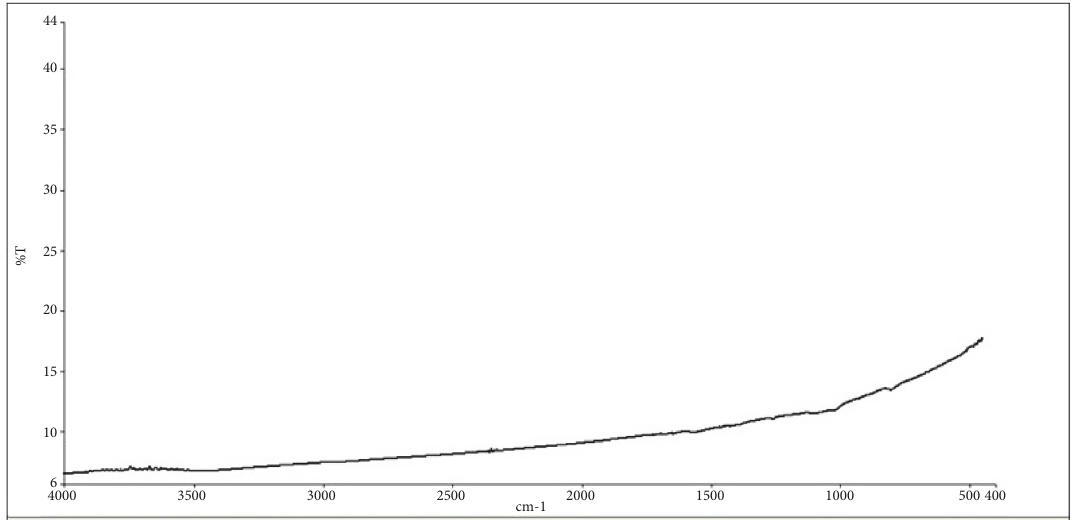
Figure 4: FTIR spectroscopy of pristine